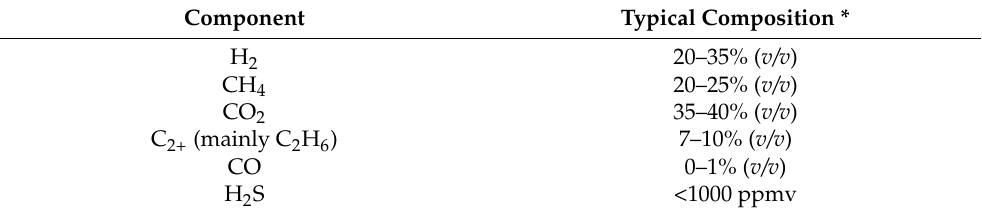
Table 1. Typical composition range of the SCWG gaseous